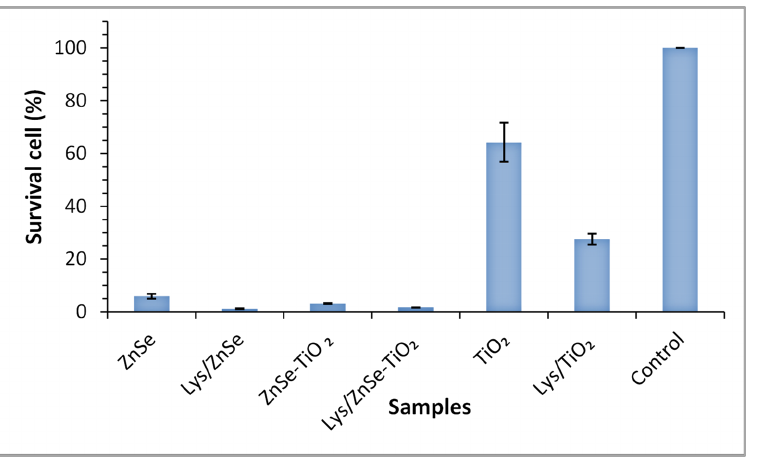
Figure 20. Cell survival percentage of Micrococcus lysodeikticus ATCC 4698 after four hours of exposure to synthesized materials. The data are presented as the mean of three independent measurements with error bars representing the standard deviation of the mean.